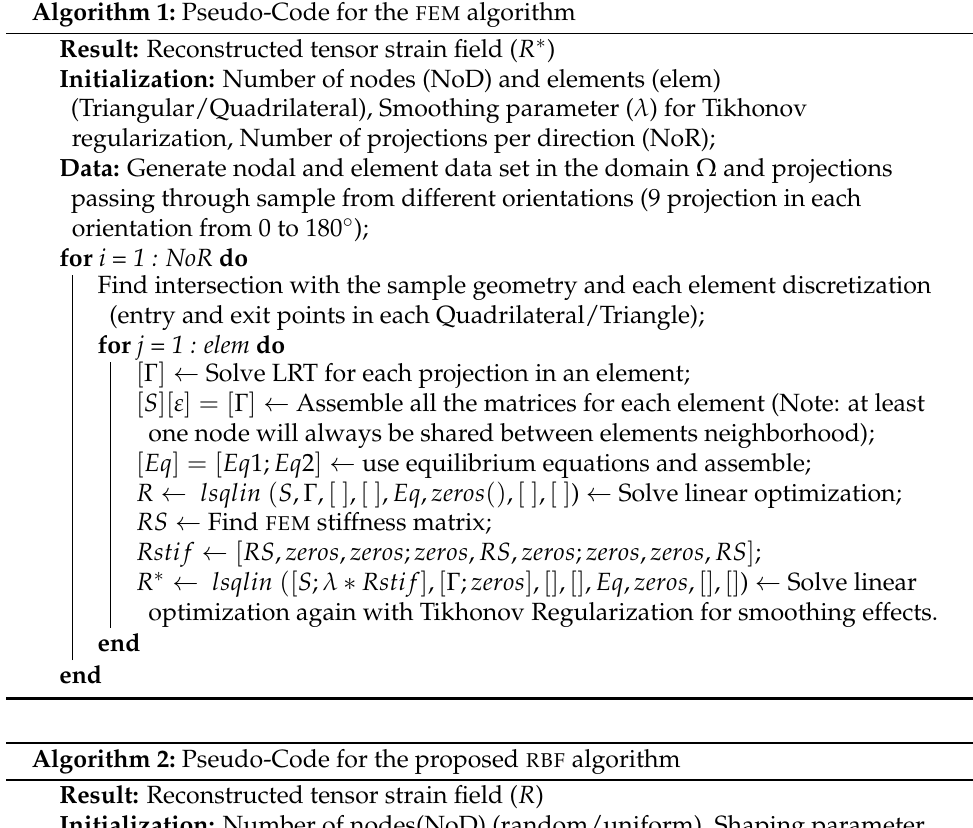
Algorithm 2: Pseudo-Code for the proposed RBF algorithm